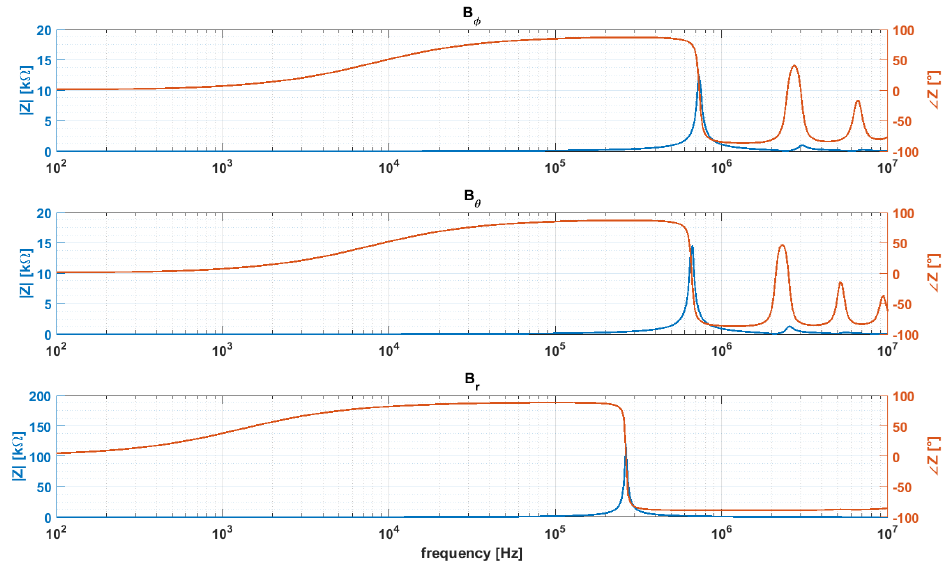
Figure 15. Frequency response in module (blue) and phase (red) of the impedance of the three prototype windings.